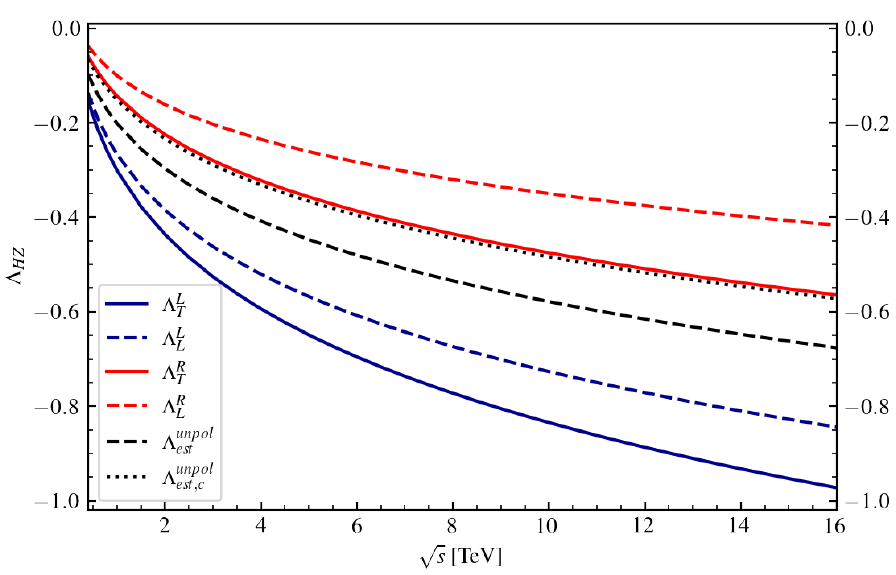
Figure 3 . Sudakov factors Λ κ for muon chiralities κ = L, R and Z polarizations λ = T, L and λ estimated unpolarized correction factor Λ unpol at θ H = 90 ◦ (black dashed) as well as Λ unpol est angular dependent terms, black dotted) for HZ production at the muon collider as a function of the √ collider energy s ,